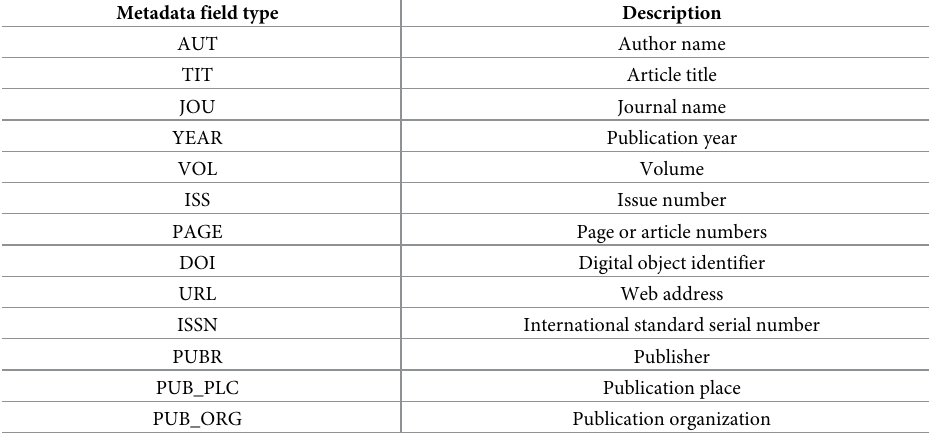
Table 2. List of metadata field types in journal